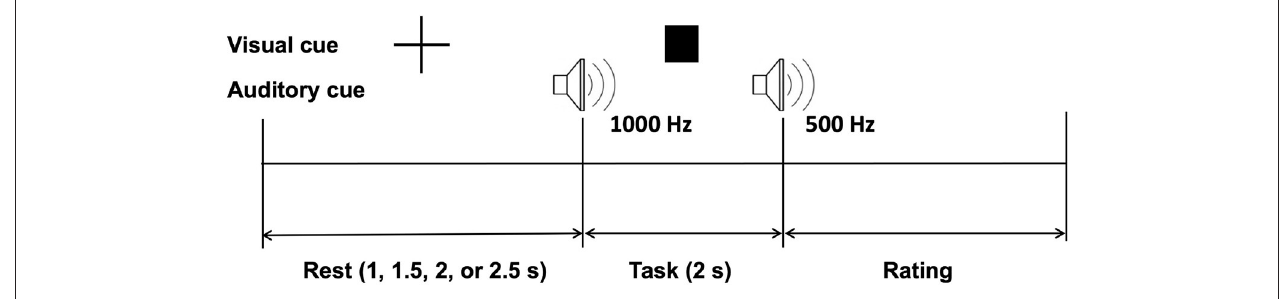
FIGURE 2 | Experimental